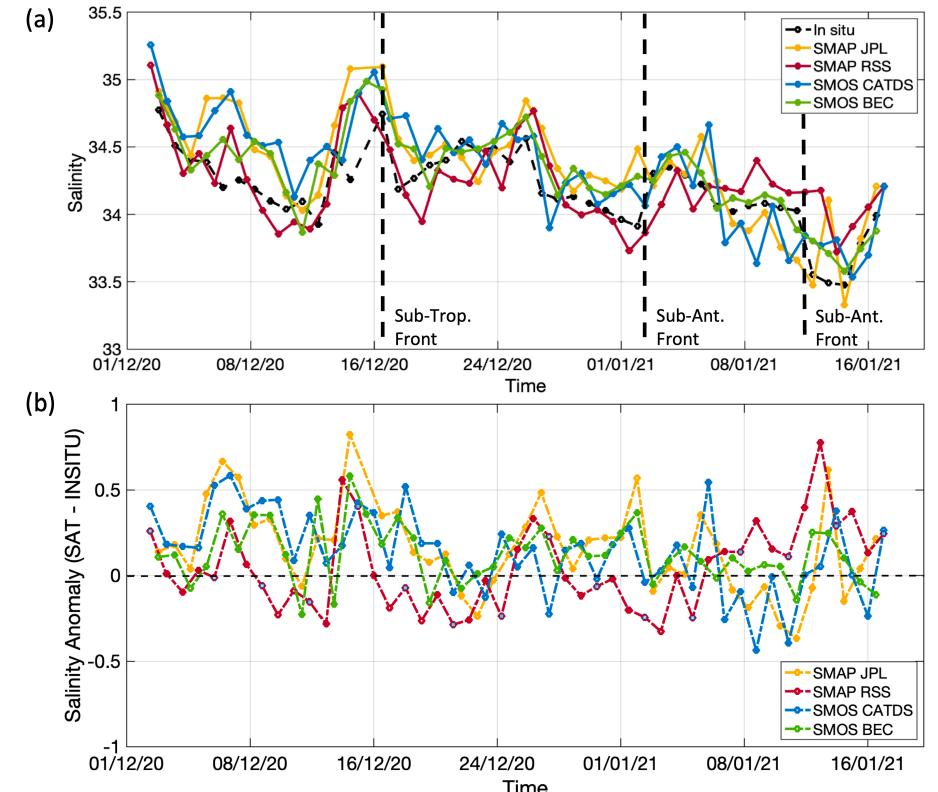
Figure 11. ( a ) Temporal evolution of daily-mean co-localized VG2020 measurements and the four satellite products along the vessel trajectory; ( b ) SSS anomaly between satellite products and VG2020 SSS